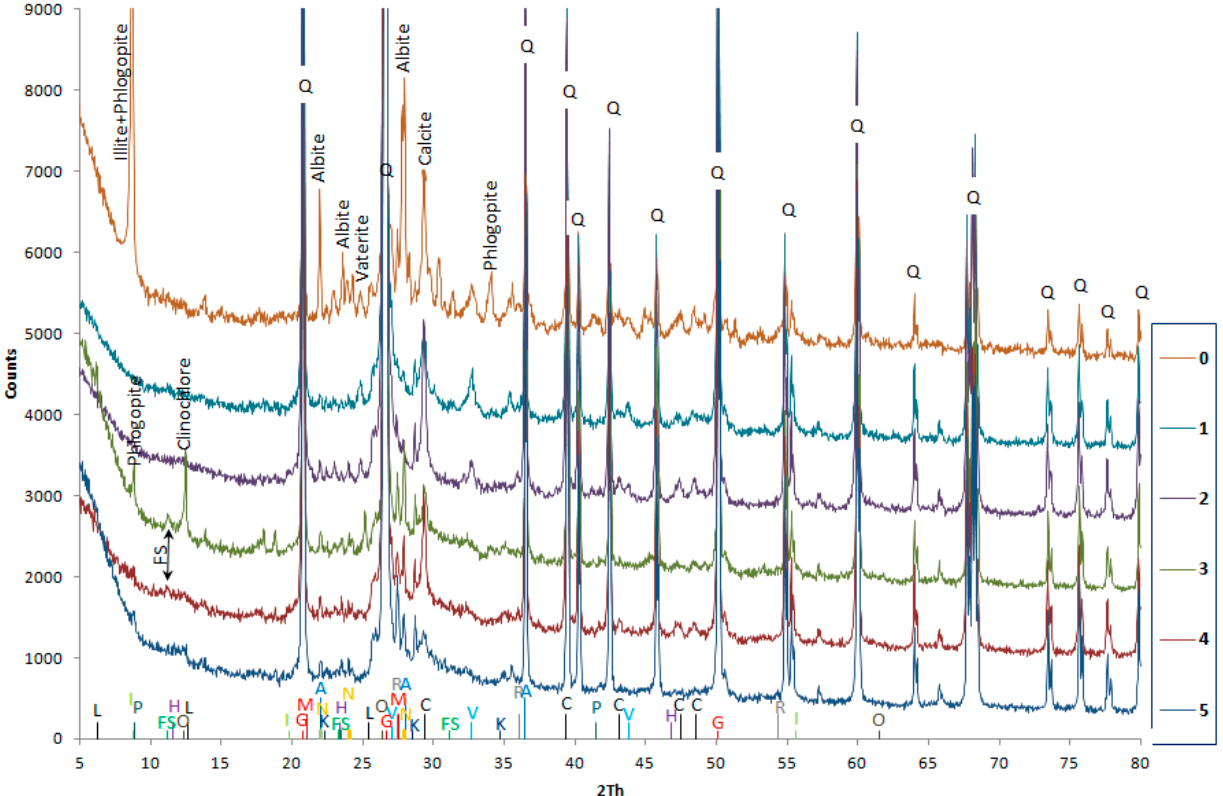
Figure 13. The XRD patterns of specimens 0 to 5.